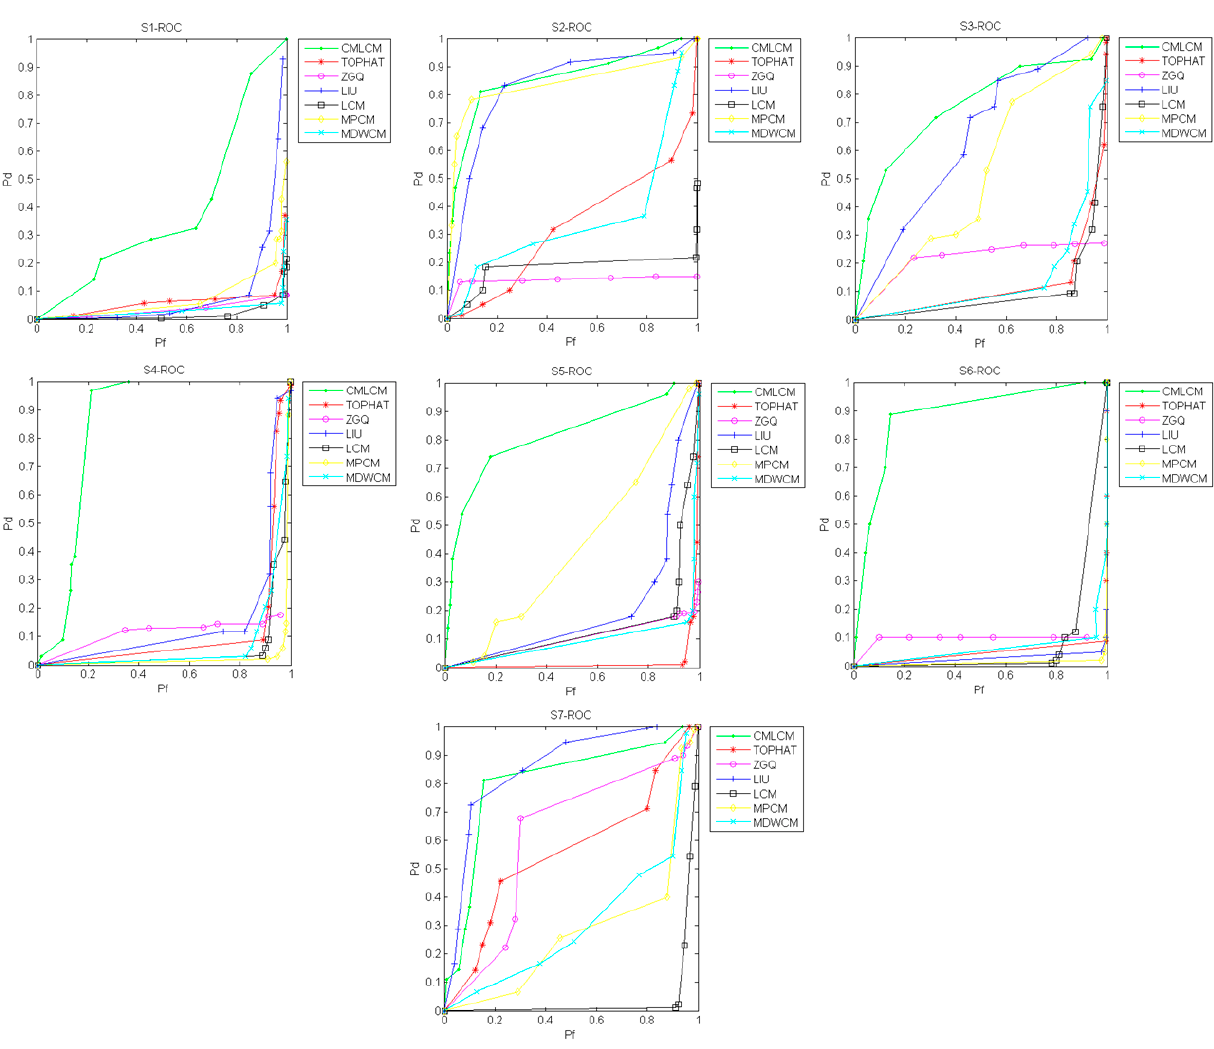
Figure 14. The ROC curves of seven sequences.